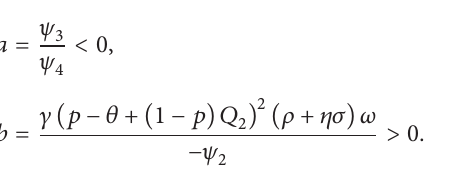
After multiple derivations, we have